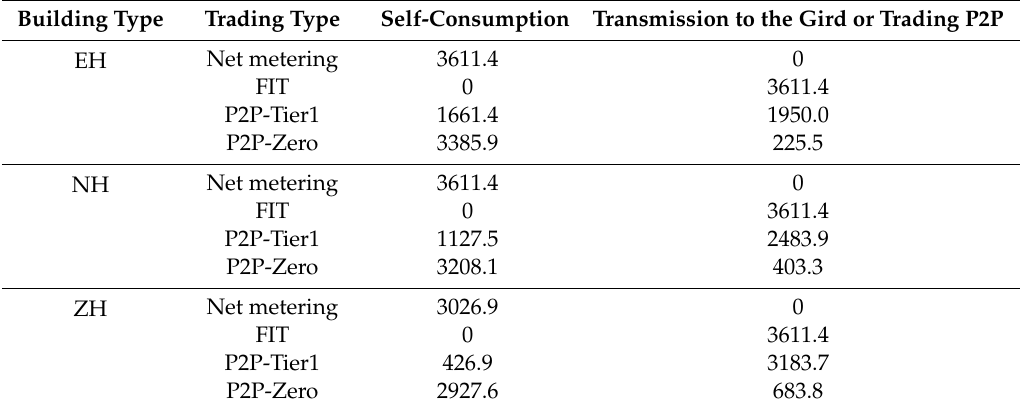
Table 16. Self-consumption and transmission of generated energy (unit: kWh / yr).